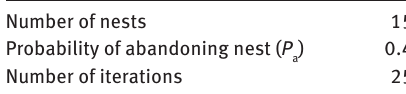
Table 1: CS Parameters.